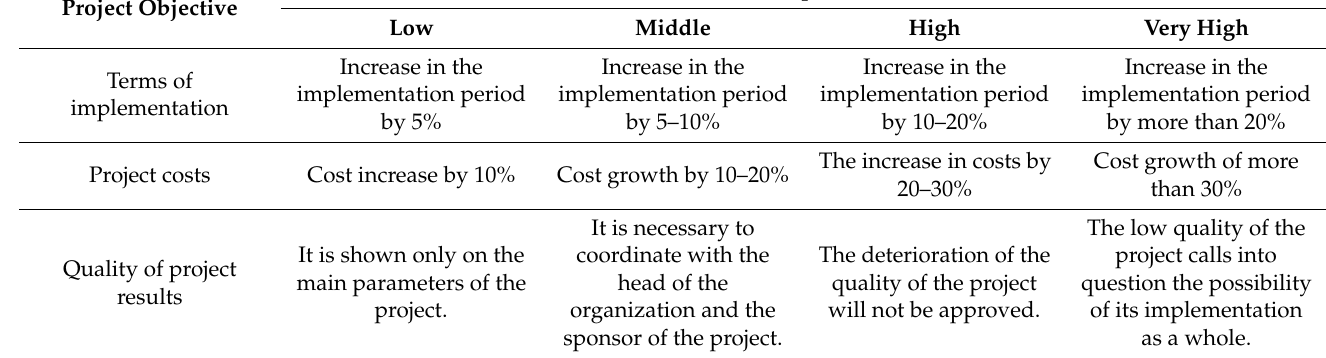
Table 2. Methodology for assessing the risks associated with the assessment of the implementation of an innovative project in accordance with Sokolova and Bondareva